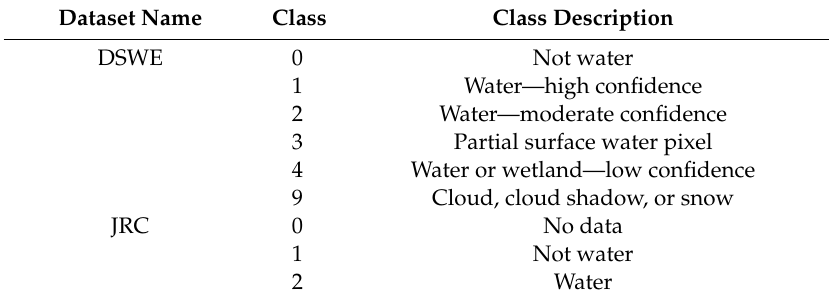
Table 1. Dynamic Surface Water Extent (DSWE) and Joint Research Centre (JRC)